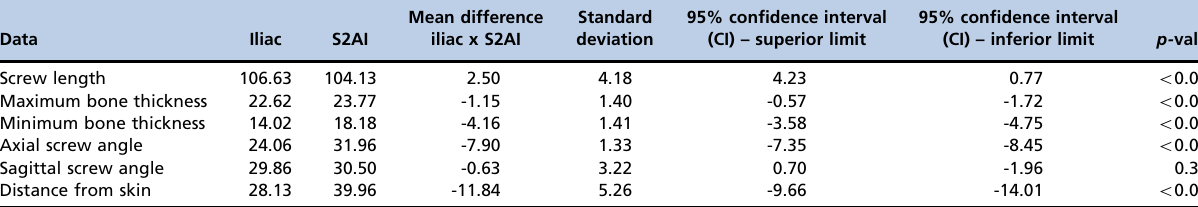
Table 1 - Mann-Whitney and Shapiro-Wilk